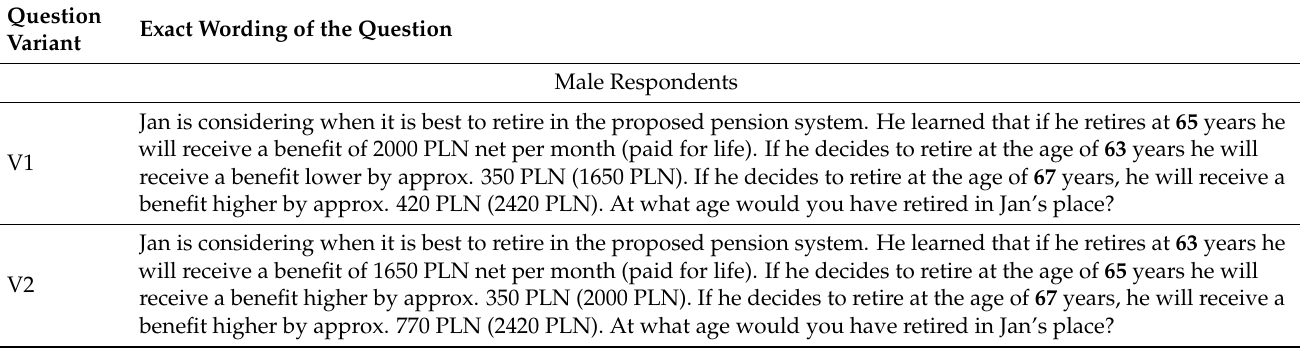
Table A1. The Wording of Different Variants of Vignette